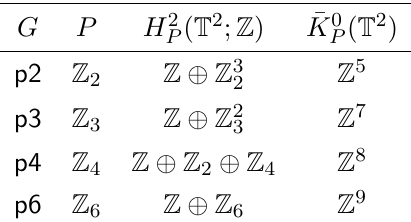
( T 2 ; Z ) ) without the P ( T 2 ) ). P